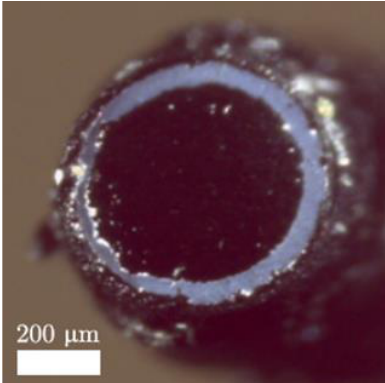
Figure 8. Image of the optical fiber’s distal end covered by reduced graphene oxide combined with PDMS. Reproduced with permission from [118].